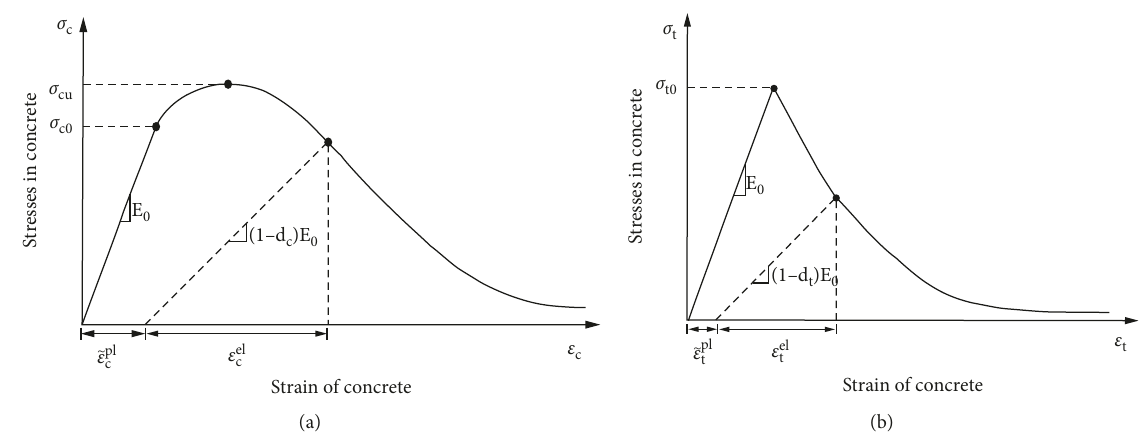
Figure 1: The uniaxial stress-strain curves of concrete (a) compression and (b)